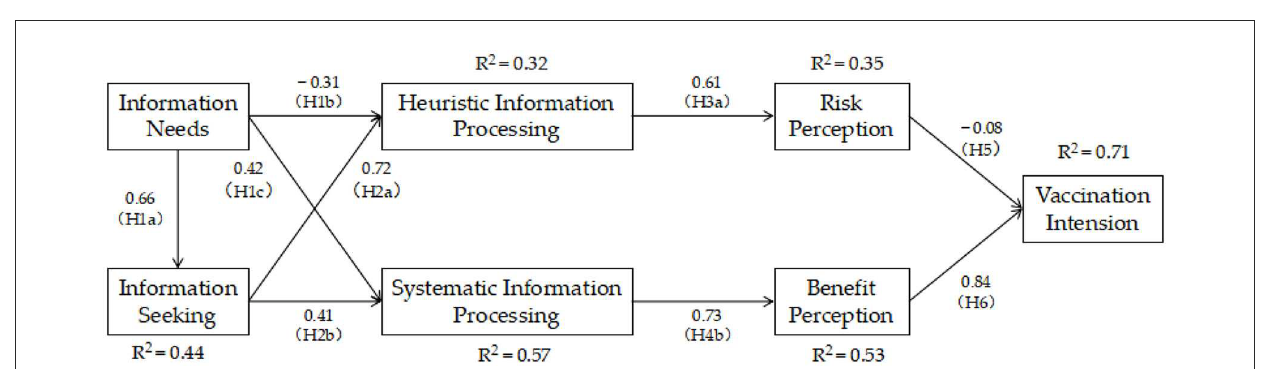
FIGURE2 The model of final research results, including path coefficients ( β ), and explained variances ( R 2 ). For example, R 2 = 0.44, means that the predictors of information seeking explain 44% of its variance.